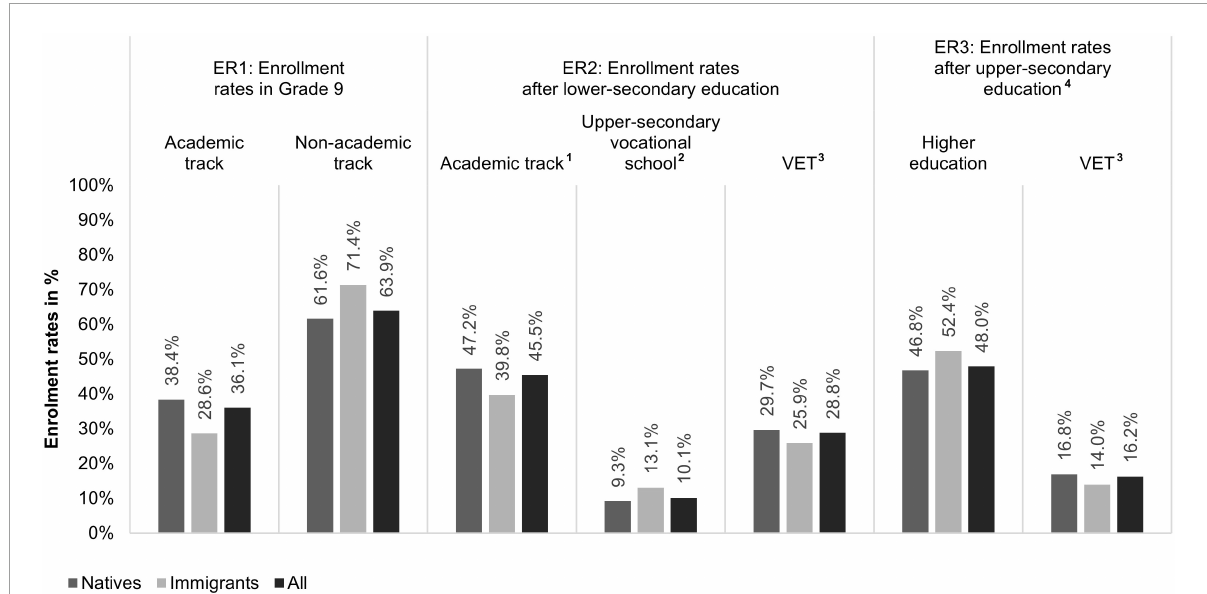
FIGURE2 Descriptive findings on students’ enrollment rates in different educational stages. 1 Attending upper-secondary school of the general school system until Grade 12 or 13. 2 Attending full-time vocational schools at upper-secondary level (e.g., Fachoberschule , Berufliches Gymnasium , etc.). 3 Entering company- or school-based vocational education and training (VET). 4 Includes only respondents who achieved an upper-secondary degree in an academic track. Imputed data ( m = 25).